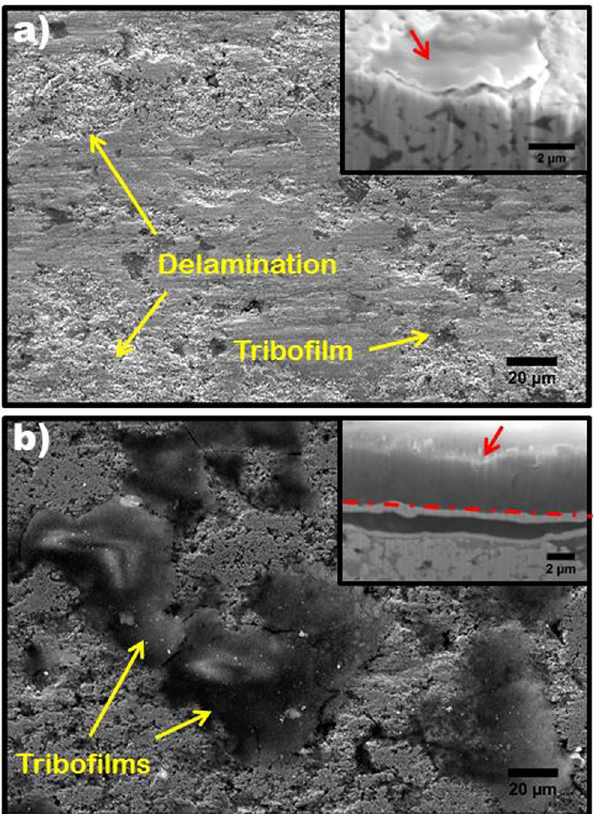
Figure 6. SEM of macro scale wear tracks; ( a ) WC-Co exhibits signs of delamination and tribofilms are typically smaller than 20 µ m, inset: FIB milled cross-section showing thickness of tribolayers in WC-Co is < 300 nm, ( b ) WC-Co-ND wear track shows large ( > 50 µ m) tribofilms and no signs of delamination, inset: FIB cross section shows thickness of tribofilms is 4–5 µ m. Red arrows denote tribofilms in insets.